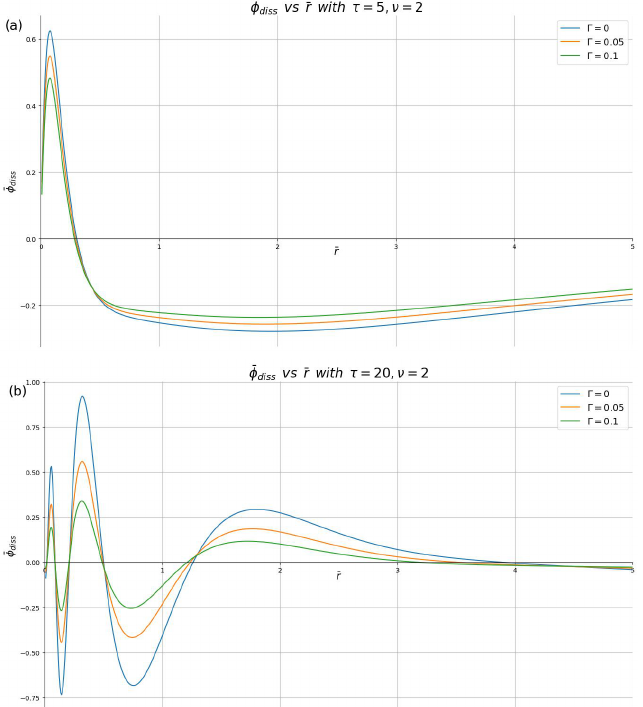
Figure 7. Dissipative part of the induced potential, ¯ φ diss in the plane z = 0, shown in reduced units against the dimensionless radial distance ¯ r for different damping parameters ( Γ = 0,0.05,0.1) with the reduced speed ν = 2, and the reduced times: ( a ) τ = 5 and ( b ) τ =